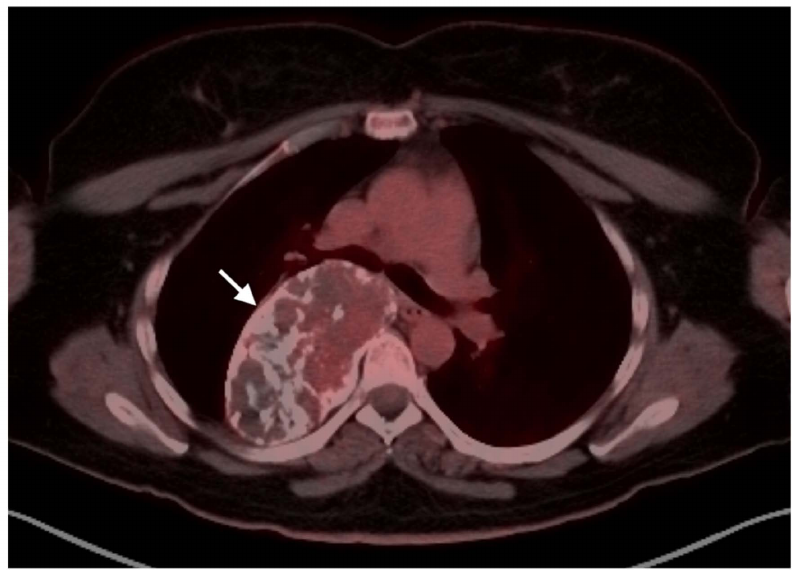
Figure 27. Ganglioneuroma. Axial FDG PET-CT image of the chest shows a large, partially calcified tumor of the right posterior chest (white arrow). These tumors arise from intercostal nerves that connect to sympathetic thoracic ganglia and are typically